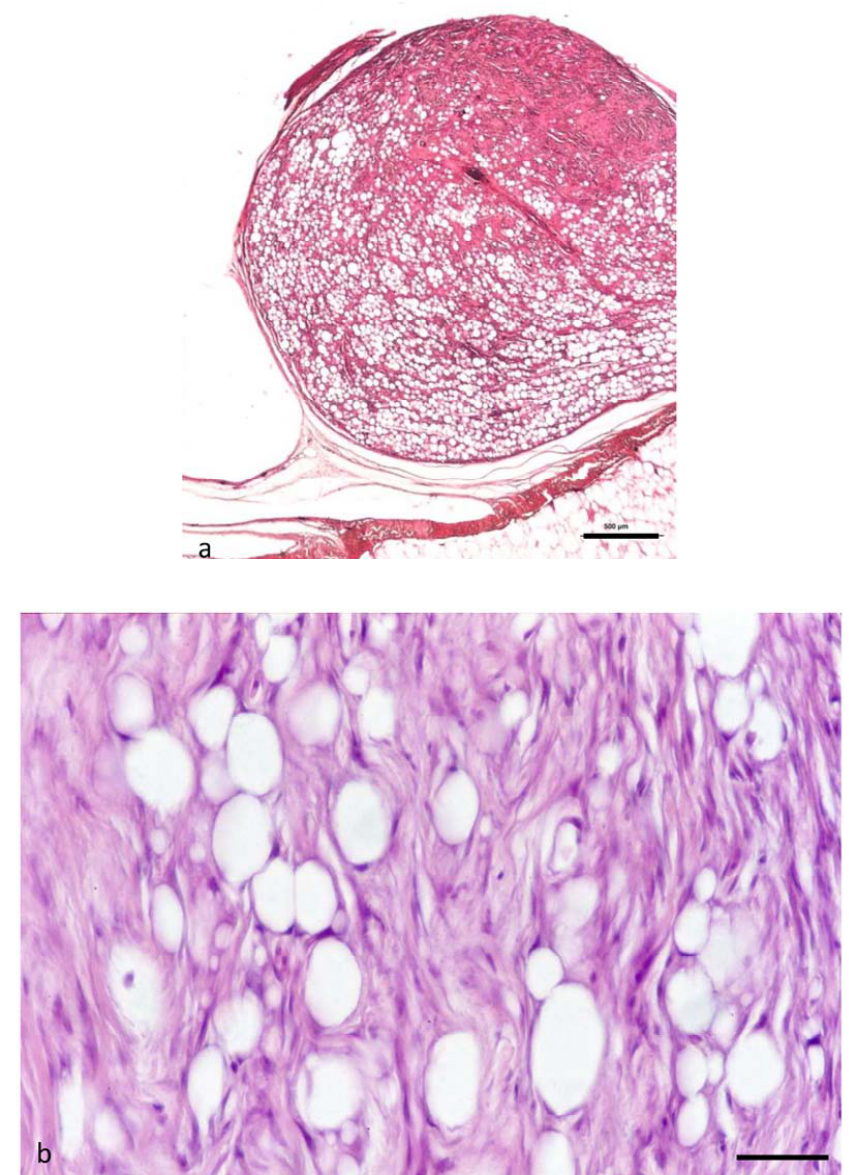
Figure 4. ( a , b ) SPINDLE CELL LIPOMA (SCL). ( a , b ). Histological section of a spindle cells lipoma. ( a ) shows a net of fibroblasts and collagen fibers surrounding mature adipocytes. Spindle cells are often located in one side of the nodule, while the other side reveals mainly adipocytes. H&E (bar = 500 μ m). ( b ) shows how spindle cells tend to be well aligned or sometimes assuming an irregular distribution pattern. These cells tend to have a mild cellular pleomorphism. H&E (bar = 50 μ